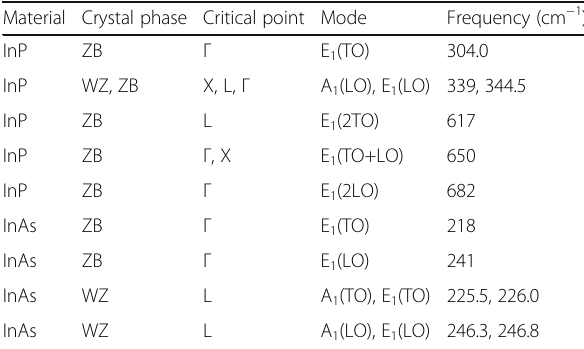
Table 1 Raman vibration modes of InP and InAs nanostructures on InP(111)B